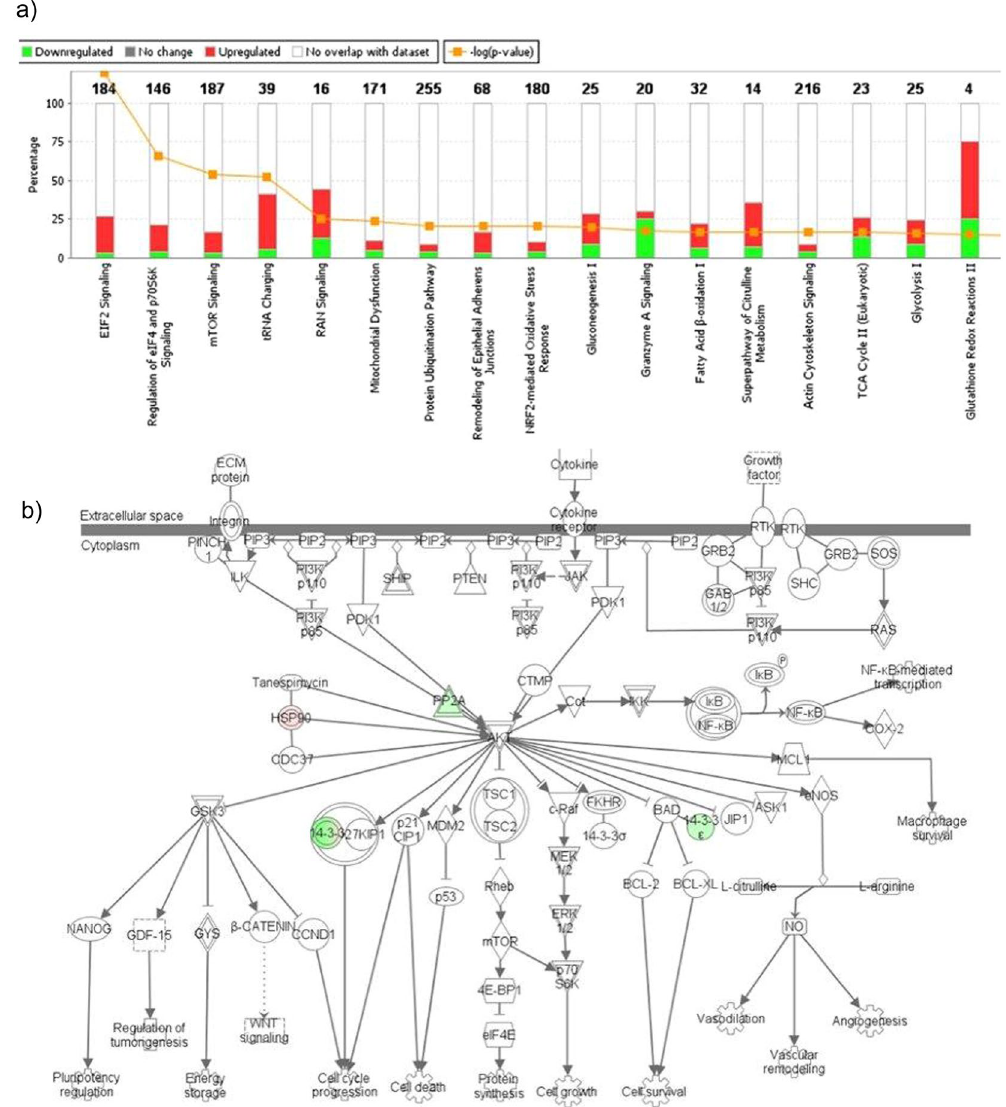
Figure 4. Proteomic analysis of H460GP and H460GR cell lines. Protein was isolated from H460GP and H460GR cell lines and analysed by bottoms-up label-free mass spectrometry, in order to identify differences in protein abundance (n = 3). 592 proteins were significantly (p < 0.05) differentially regulated (fold change > 2) between parent and GDC-0980 resistant cells. Data was analysed using Ingenuity Pathway Analysis. ( a ) Top dysregulated pathways are shown. ( b ) Differential regulation is shown in the context of the PI3K